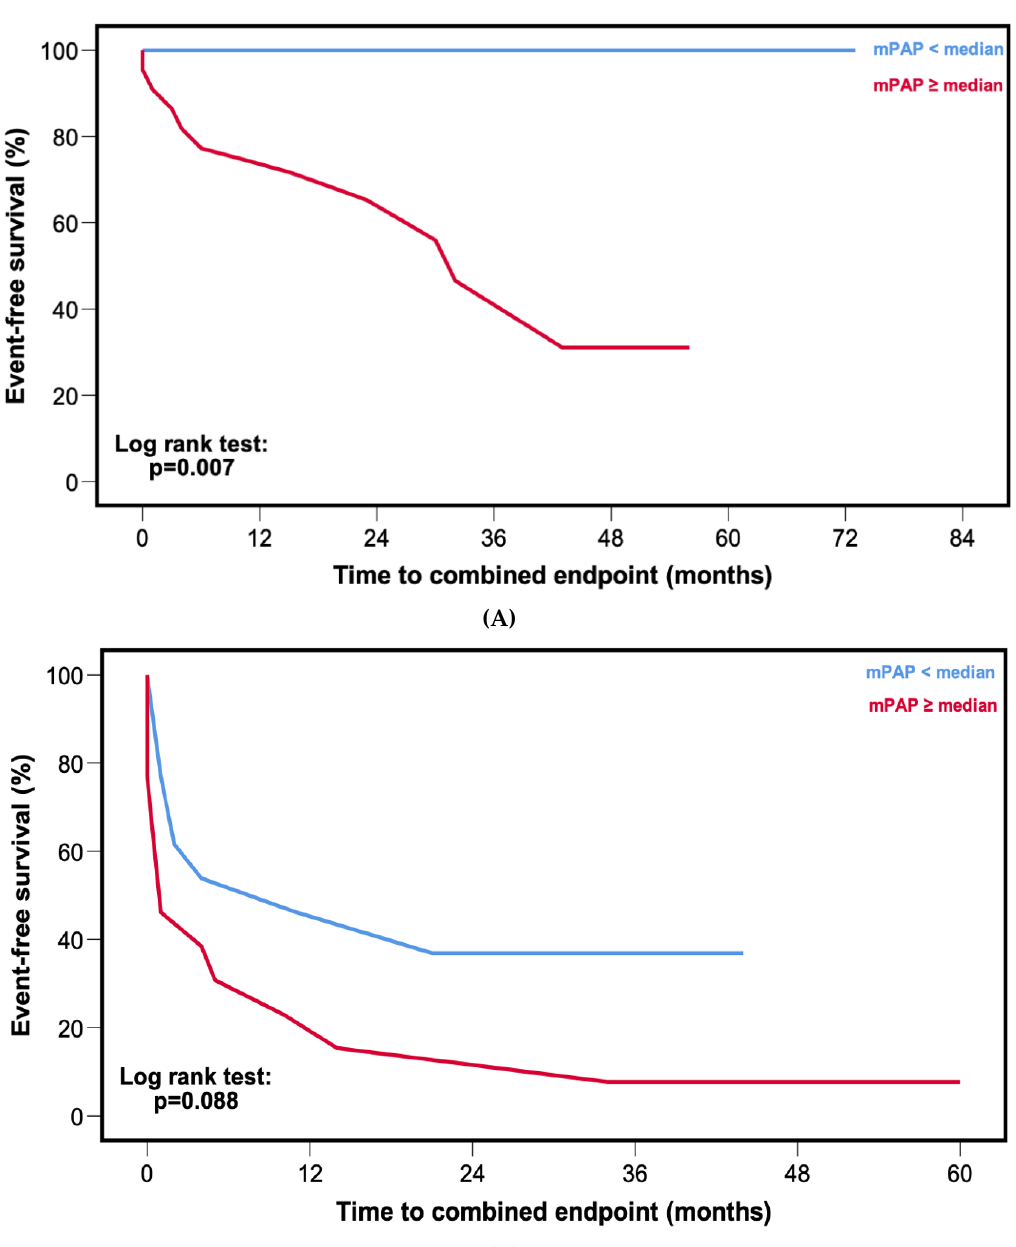
Figure 2. Kaplan–Meier curves for event-free survival stratified by median mean pulmonary arterial pressure (mPAP). ( A ) Patients with cardiac wild-type transthyretin amyloidosis. ( B ) Patients with cardiac light-chain amyloidosis. Table 2. Cox regression analysis for the cardiac wild-type transthyretin amyloidosis cohort. Adjusted 95% Crude 95% p p hazard Confidence Variable hazard Confidence value value ratio interval ratio interval Univariable regression Multivariable regression Clinical parameters Age, years